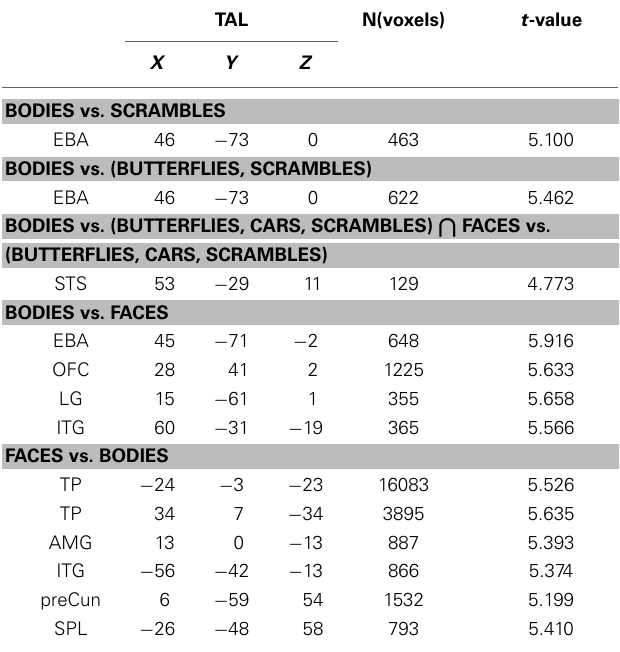
Table 2 | Activations for presentation of faces and bodies compared to butterflies, cars and scrambles.